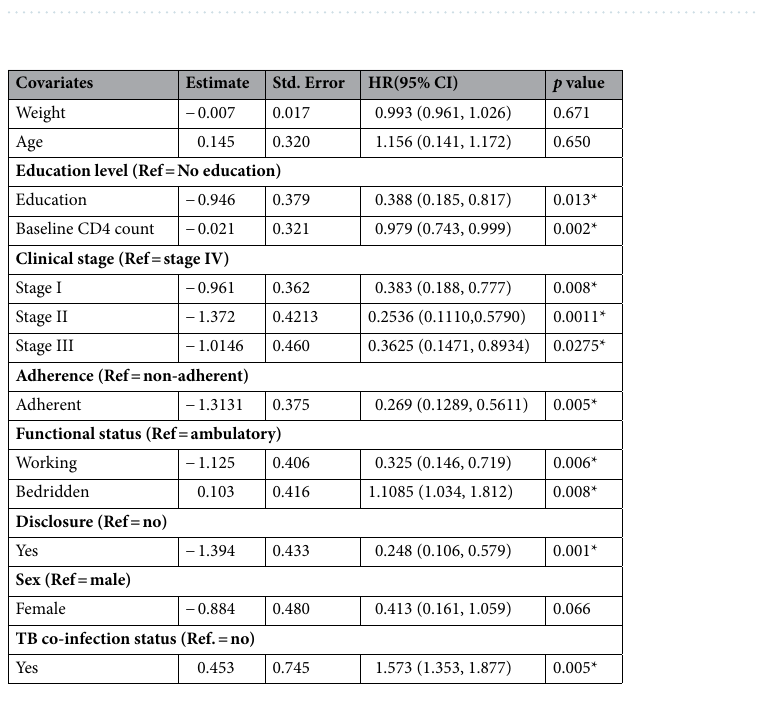
Table 2. Results for the predictors of the longitudinal CD4 count sub-model (response = CD4 count). *Stands for statistically significant variable at 5% level of significant.